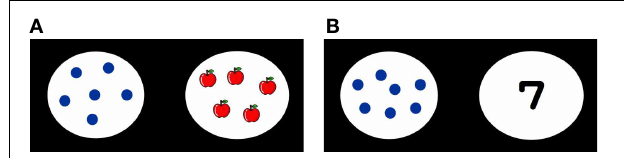
FIGURE 2 | An example of the stimuli for (A) non-symbolic numerical matching task and (B) symbolic numerical matching task.